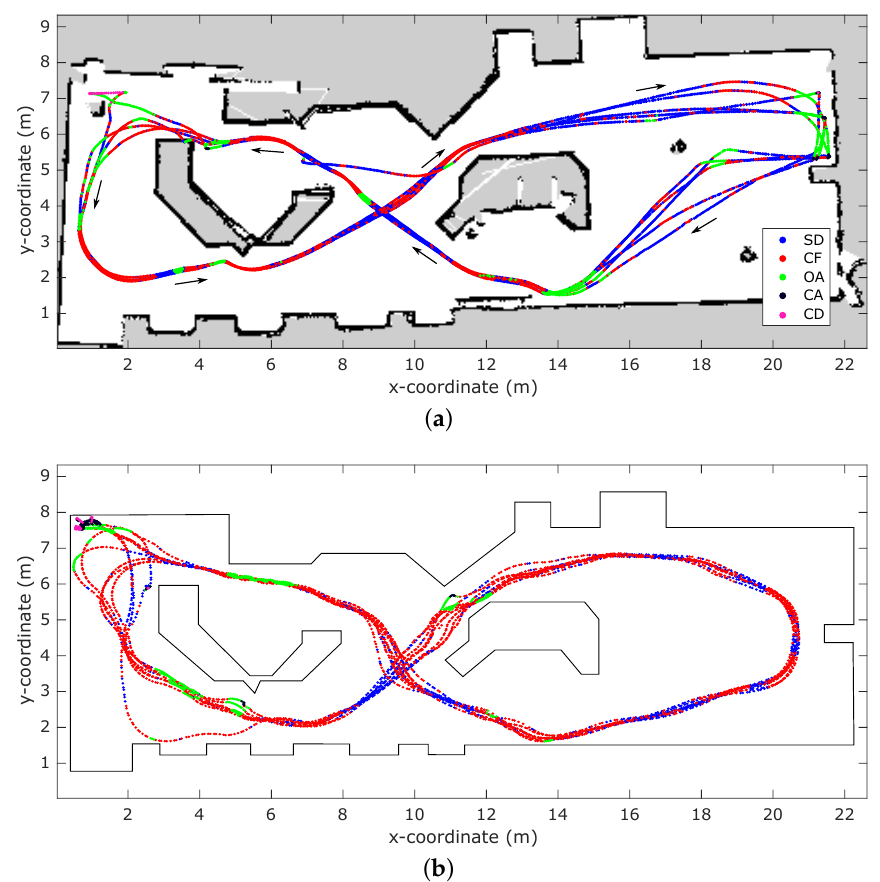
Figure 6. Comparison of the behavior control results of a real-world experiment versus a simulated experiment. Each dot represents a pose of the vehicle. Dots are colored according to the active behavior at that moment. ( a ) Active behaviors for the trajectory of vehicle in a real-world exper- iment from previous work. ( b ) Active behaviors for the trajectory of the simulated vehicle in the virtual